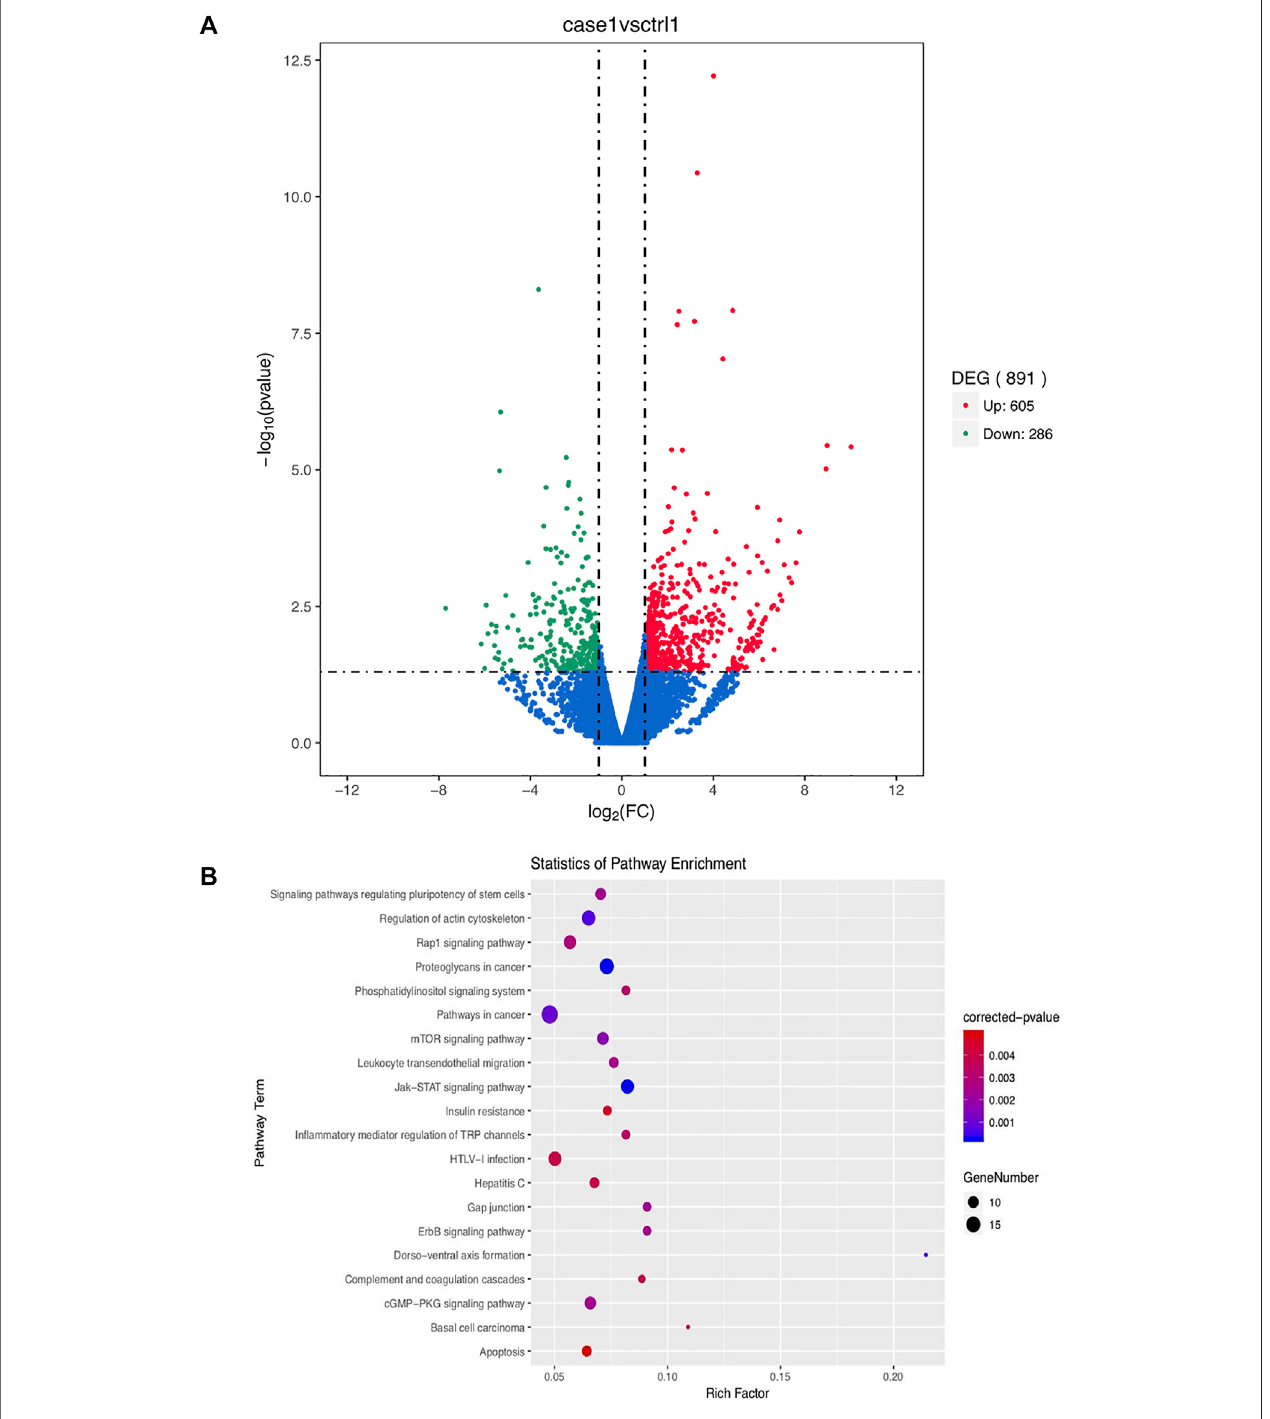
FIGURE 6 | The results of RNA-seq, (A) : Volcano plot of differentially expressed genes (DEGs) between 10%CGF and control group in directly co-cultured hBMSCs, (B) : Representative up-regulated KEGG pathway categories, (C) : mRNA expression level of MAP2K1, ULK1, PIK3CA (* p < 0.05).